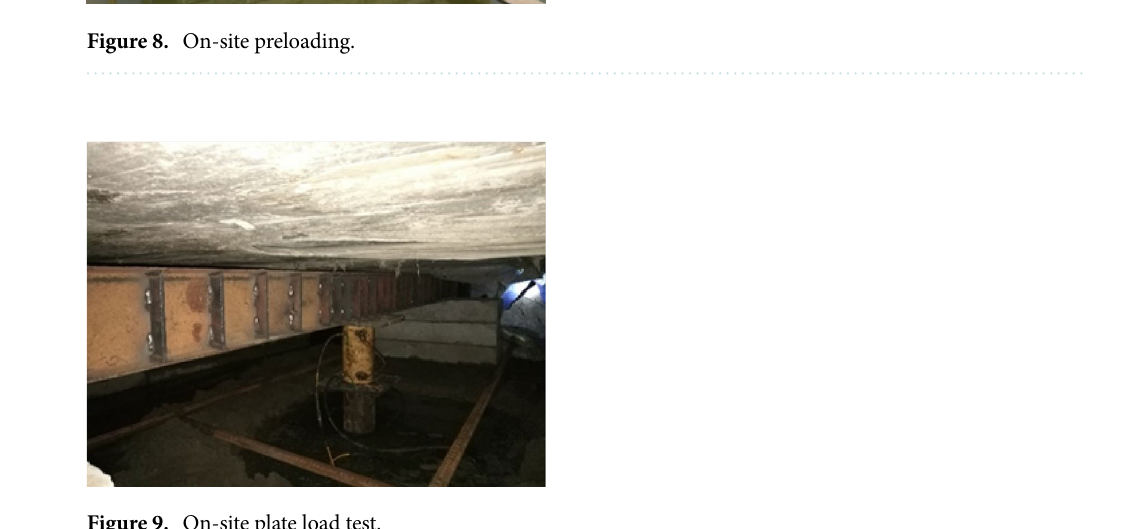
Figure 9. On-site plate load test.